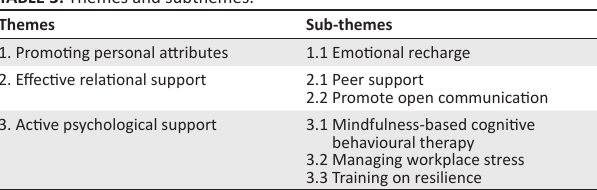
TABLE 3: Themes and